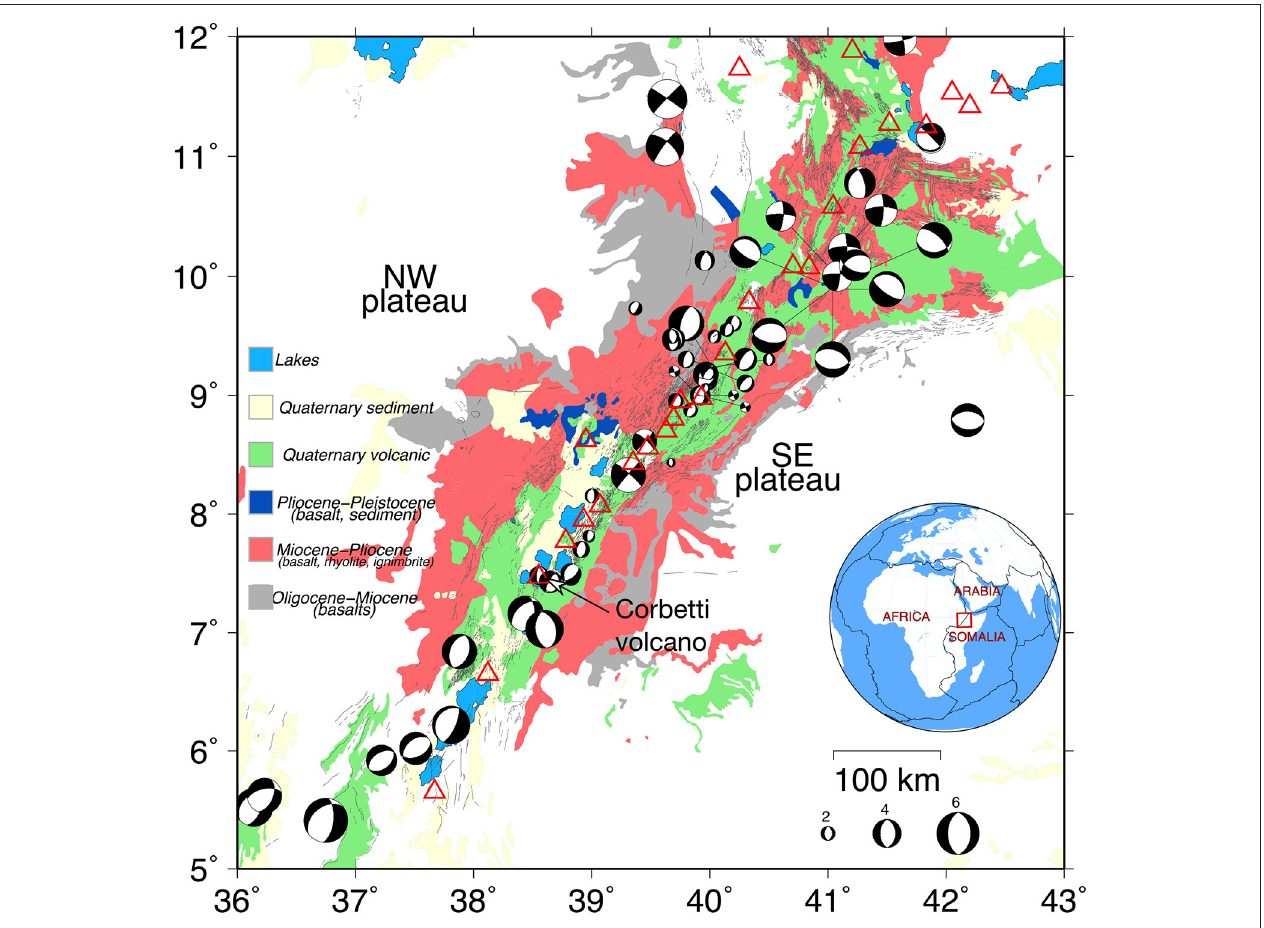
FIGURE 1 | Location of the Main Ethiopian Rift (MER) and adjacent plateau. Earthquakes focal mechanisms are taken from Hofstetter and Beyth (2003) and Keir et al. (2006). The geology and faults are taken from 1:2M scale geological map (Tefera et al., 1990). The open red box on the inset map shows the location of the main map. The red triangles show active